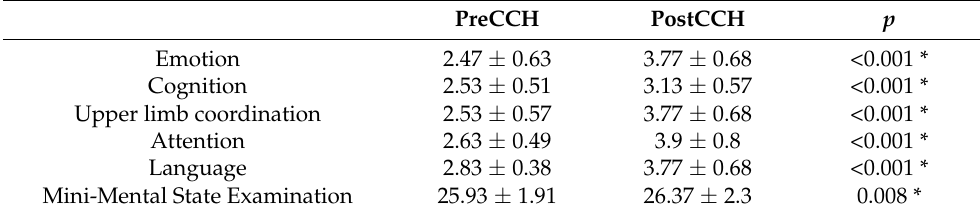
Table 2. Functional changes before and after Chinese calligraphy handwriting